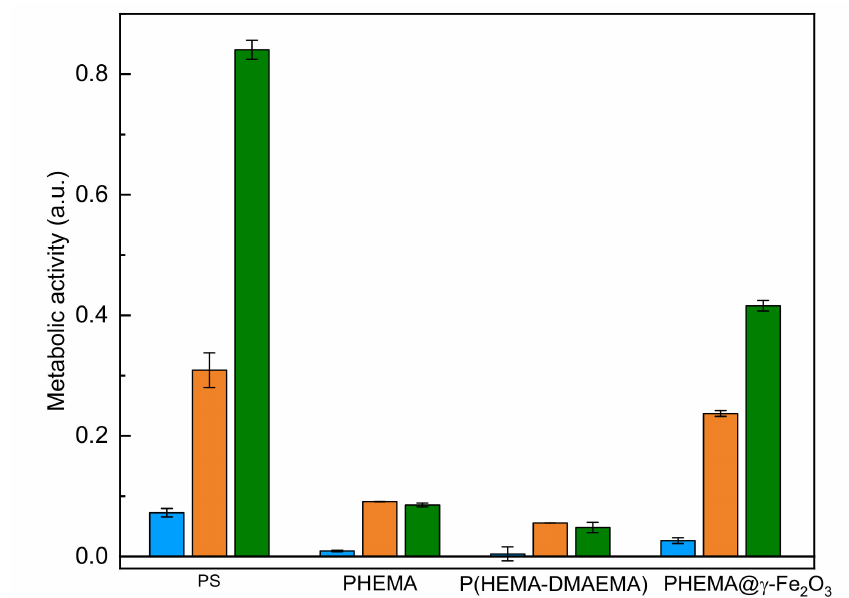
Figure 5. Metabolic activity of SAOS-2 cells cultivated for 1 (blue), 3 (orange), and 7 days (green) on poly(2-hydroxyethyl methacrylate) (PHEMA), poly(2-hydroxyethyl methacrylate- co - 2-dimethylaminoethyl methacrylate) [P(HEMA-DMAEMA)], and PHEMA containing γ -Fe 2 O 3 nanoparticles (PHEMA@ γ -Fe 2 O 3 ). PS—polystyrene culture